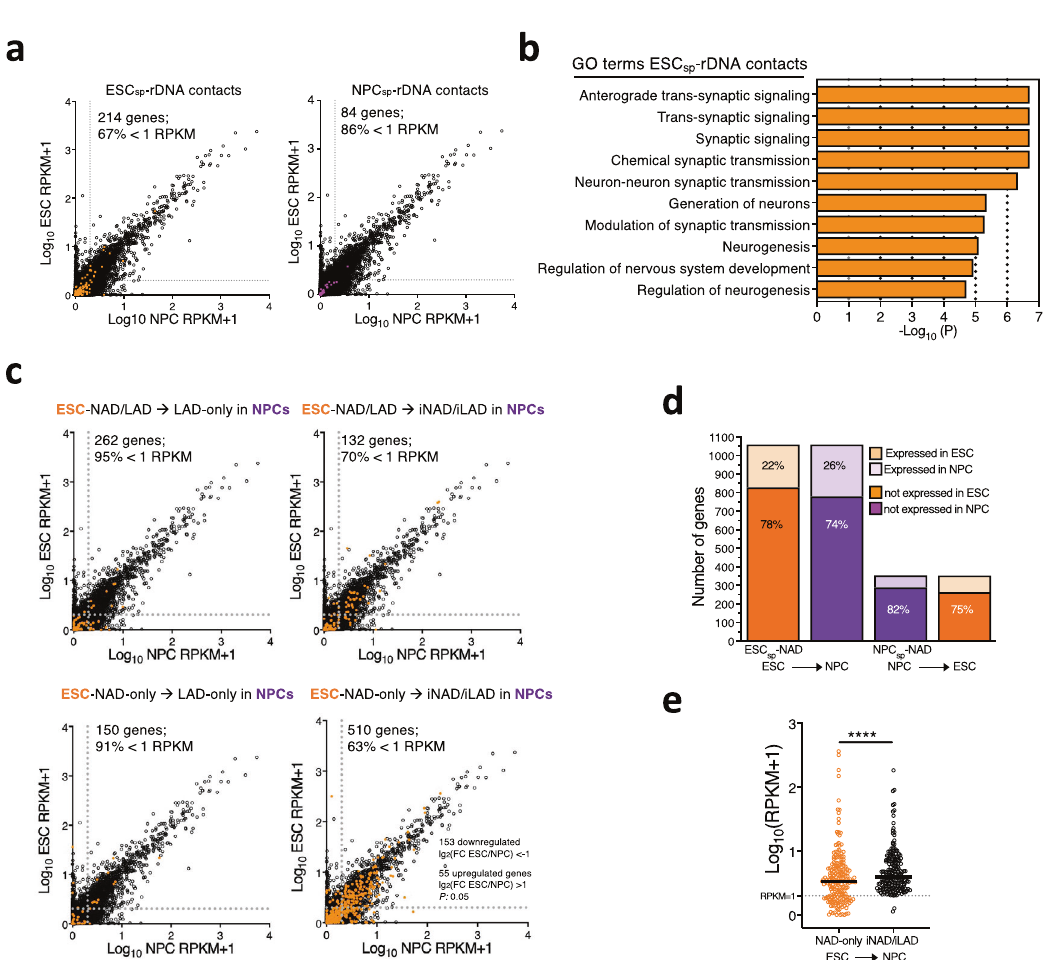
Fig. 7 NAD detachment from the nucleolus unlock genes for activation in later stages of differentiation. a Scatter plot showing expression levels between ESC and NPCs. Expression of genes located at ESC sp - and NPC sp -rDNA contacts are highlighted in orange and magenta, respectively, whereas total genes are represented in black. Dotted lines indicate RPKM value as 1. b Top 10 gene ontology terms of genes located at ESC sp -rDNA contacts. c Scatter plot showing gene expression levels between ESC and NPCs. Expression of genes located at ESC sp -NAD-only and ESC sp -NAD/LAD that become LAD-only or iNAD/iLAD in NPCs. Genes located at ESC sp -NAD are highlighted in orange, whereas total genes are represented in black. Dotted lines indicate RPKM value as 1. d Number of genes located at ESC sp -NAD and NPC sp -NAD. The proportion of low or not expressing (<1 RPKM) and expressing genes in ESCs and NPCs is indicated. e Expression levels of genes located at ESC sp -NAD-only that become iNAD/iLAD in NPCs. Values are from genes that were expressed (> RPKM 1) in ESCs or NPCs. Statistical signi fi cance ( P -values) was calculated using the paired two-tailed t test (****<0.0001). Source data are provided as a Source Data fi